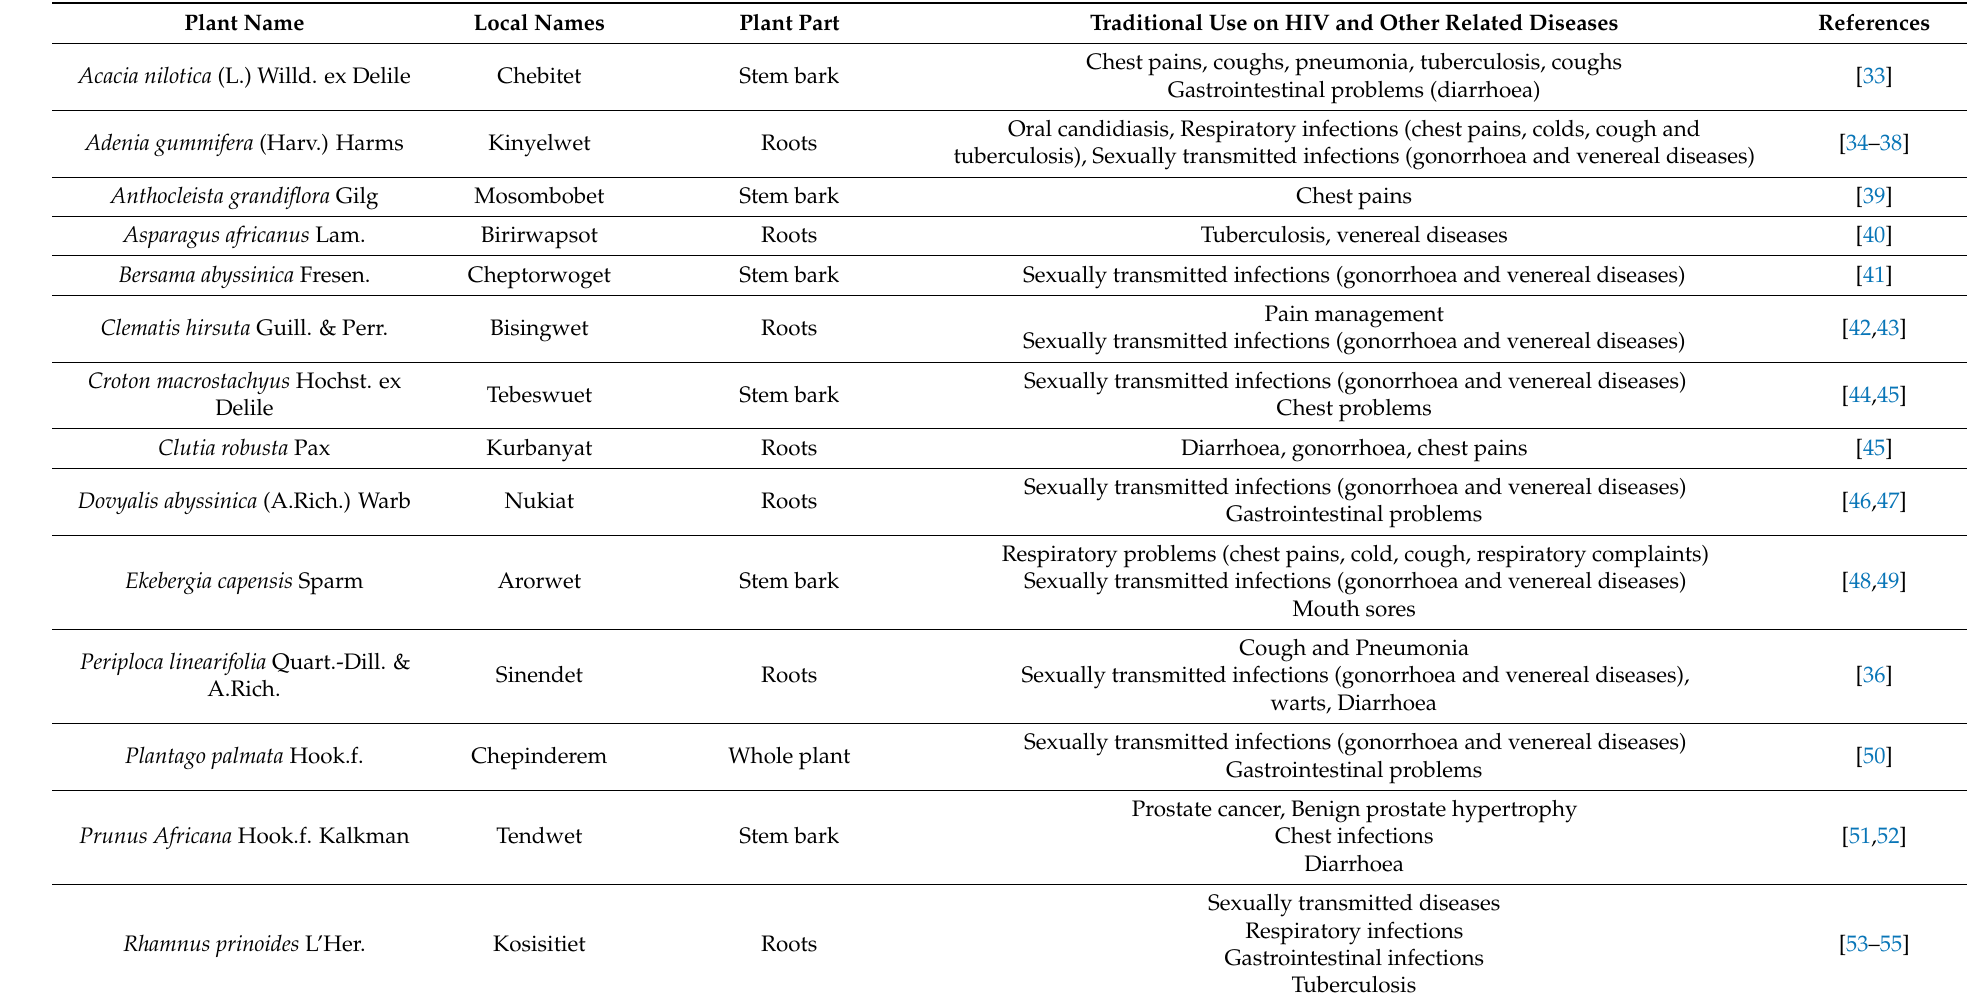
Table 3. Documented ethnomedicinal uses of the 14 medicinal